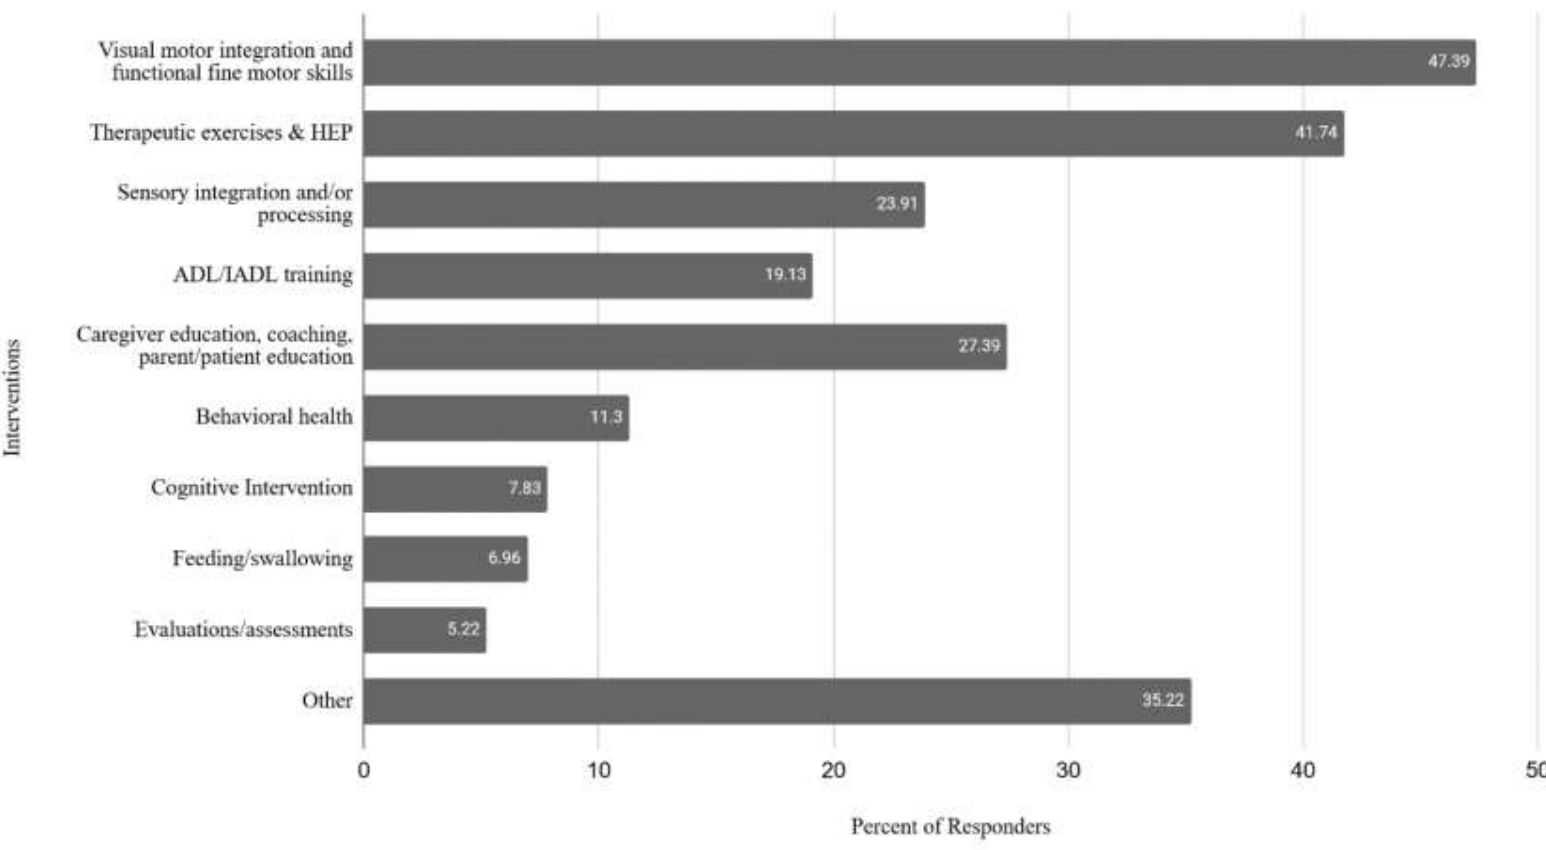
Figure 3 Percentages for Interventions that were Effectively Used via